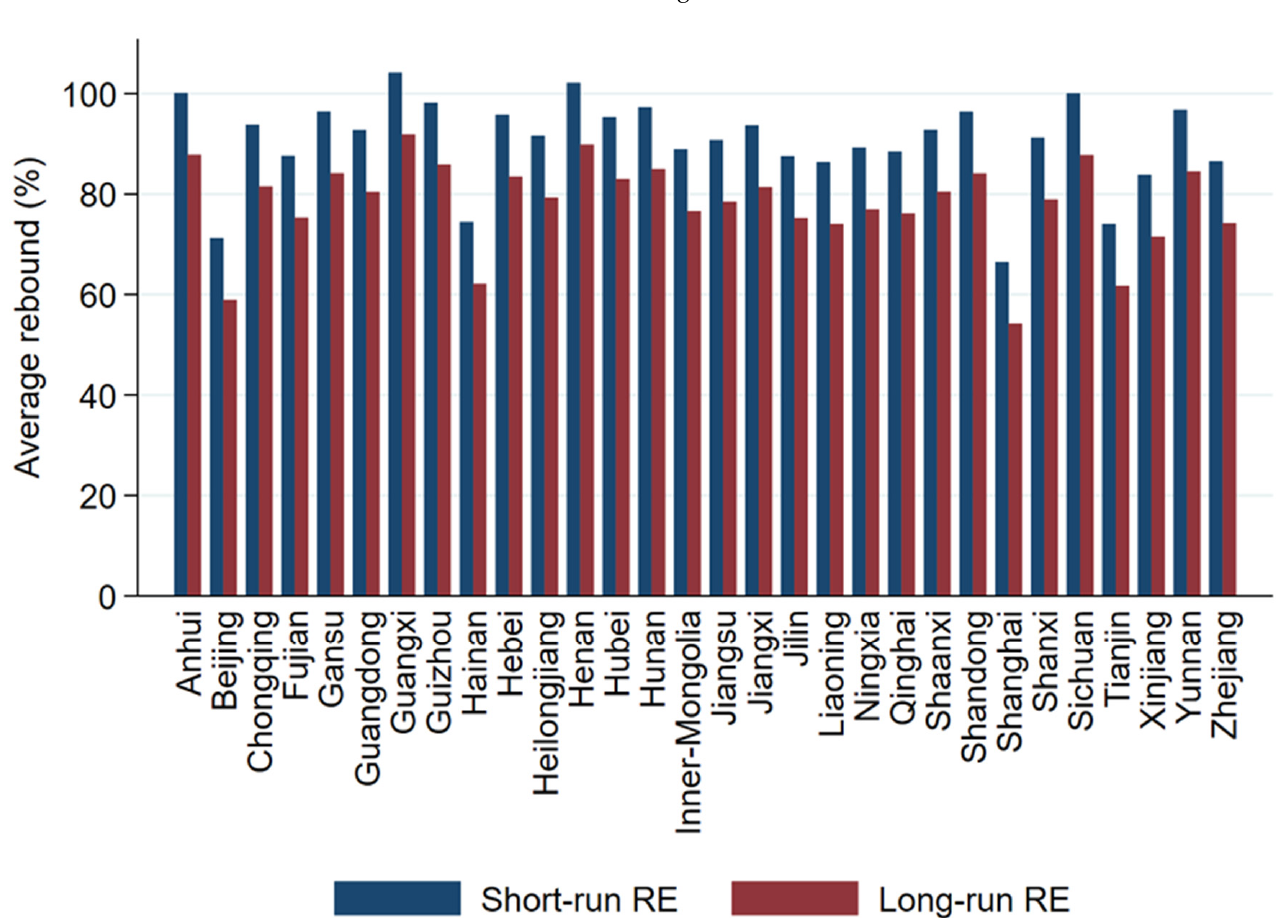
Figure 4. Average RE of 30 Chinese provinces in the short and long run.